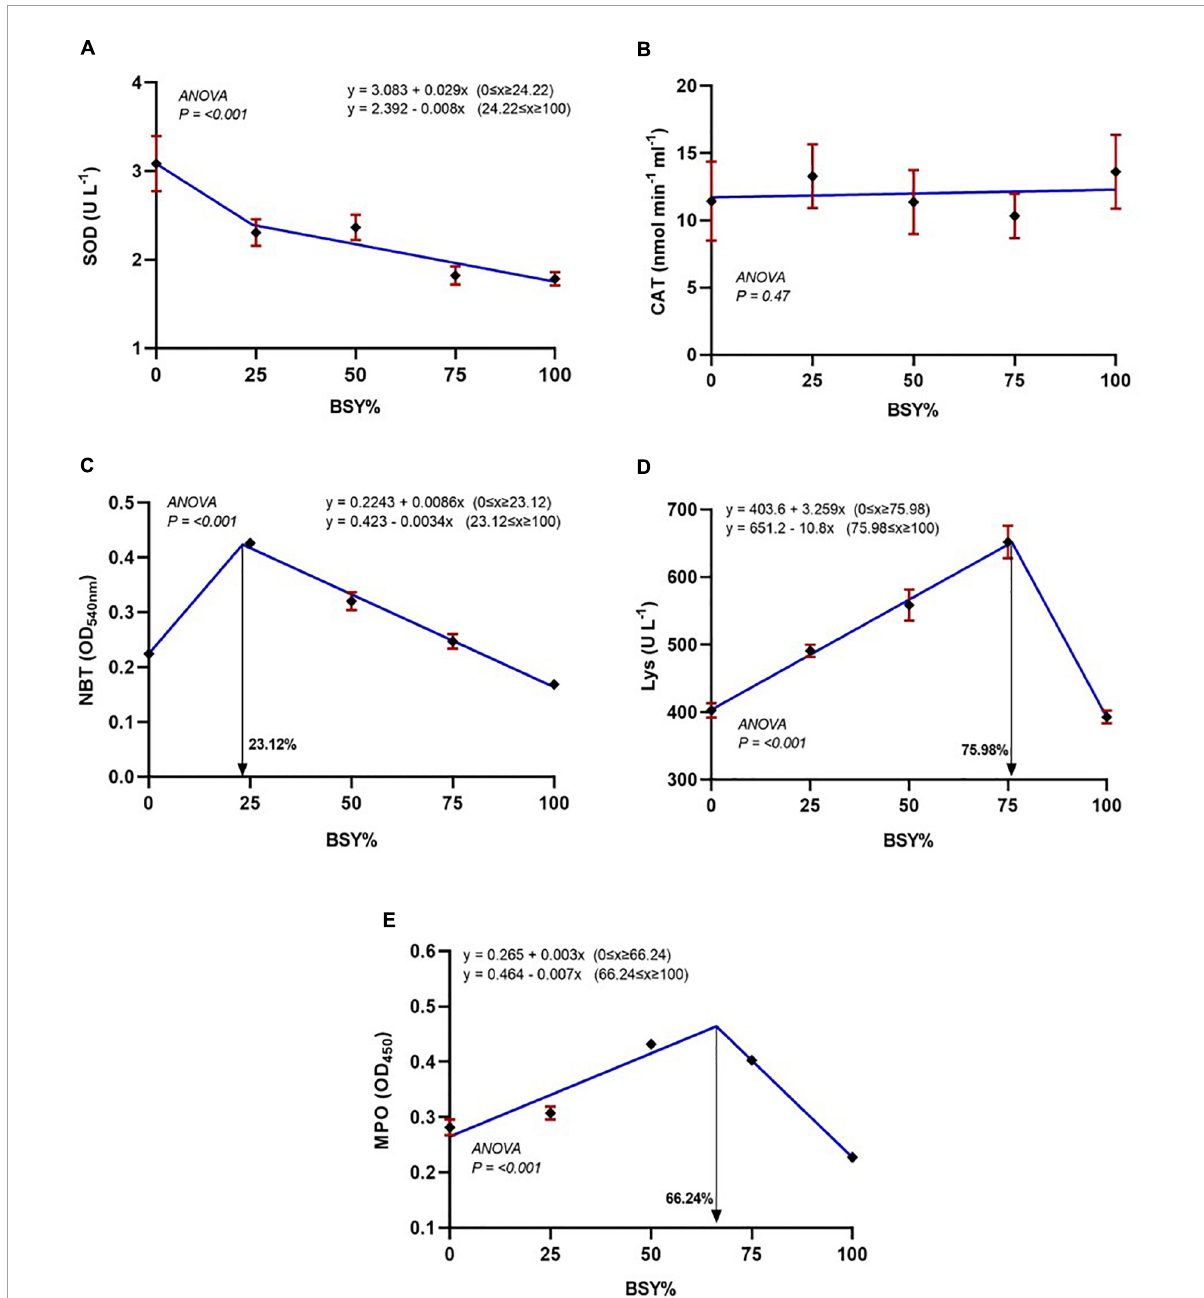
FIGURE5 Serum antioxidant and Immunological responses of climbing perch fingerlings fed with BSY incorporated diet for 60 days. The X-axis represents the gradient inclusion levels of BSY in the place of fishmeal. (A) SOD, Superoxide dismutase (U L − 1 ); (B) CAT, Catalase (nmol min − 1 .ml − 1 ); (C) NBT, Respiratory burst activity (OD 540 nm ); (D) Lys, Lysozyme levels (U L − 1 ) and (E) MPO, Myeloperoxidase (OD 450 nm ). The values are expressed as Mean ± SD, n =